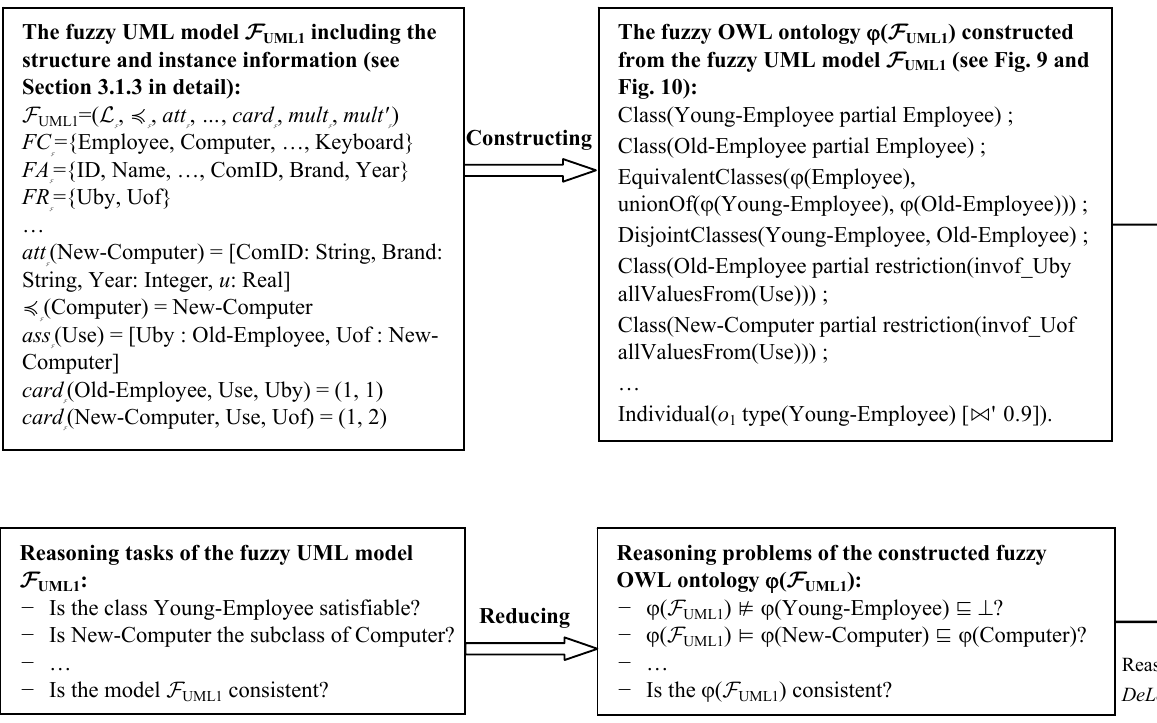
Fig. 14. Reasoning on the fuzzy UML model F UML1 in Section 3.1.3 with the constructed fuzzy OWL ontology ϕ ( F UML1 ).